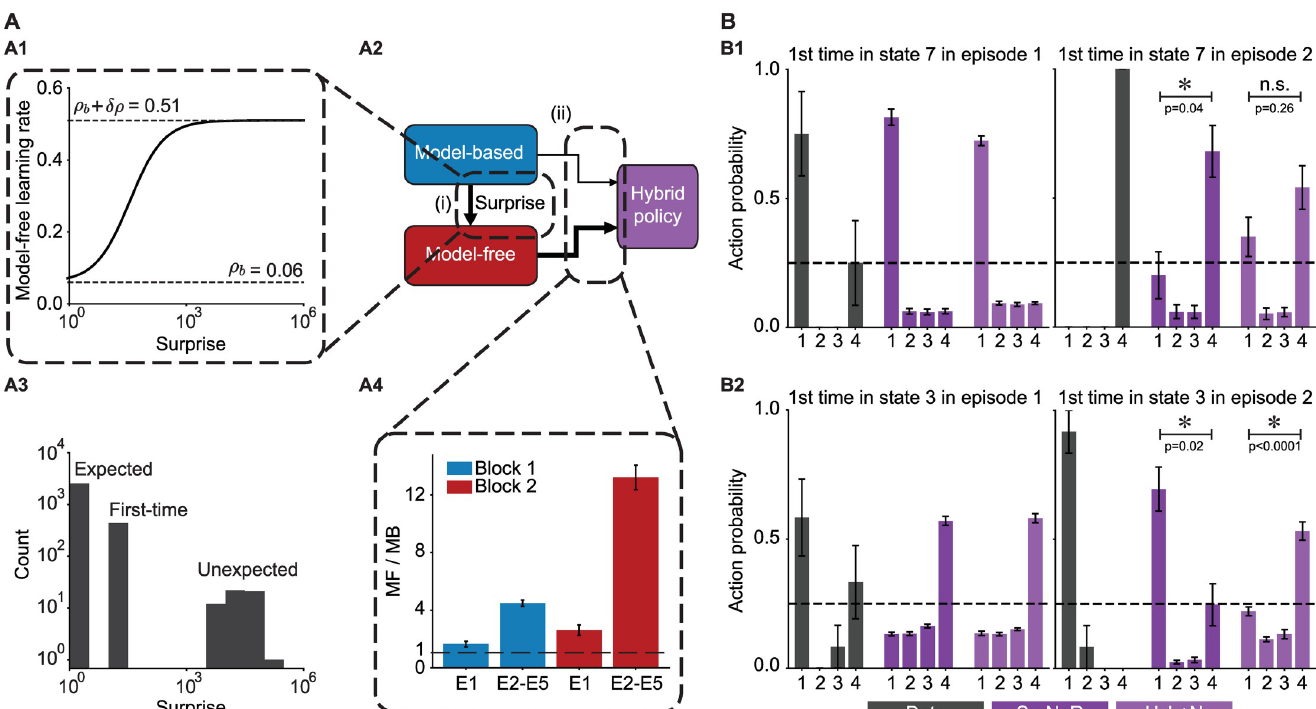
Fig 6. A . Model-based surprise modulates model-free learning . A1 . The learning rate of the model-free branch as a function of the model-based surprise, after fitting parameters to the behavior of all participants (see Eq 9 in Methods). The model-free learning rate for highly surprising transitions is more than 8 times greater than the one for expected transitions. A2 . Three modules from the block diagram of Fig 4C. There are two types of interactions between the model-based and the model-free branches of SurNoR: (i) The model-based branch modulates the learning rate of the model-free branch and (ii) the weighted (arrow thickness) outputs of the model-based and the model-free branches influence action selection (hybrid policy). A3 . The histogram of surprise values across all trials of 12 participants. The distribution is multimodal with high surprise for the unexpected transitions in the 1st episode of block 2, medium surprise for whenever a transition is experienced for the first time, and low surprise for the expected transitions. A4 . The relative importance of model-free (MF) compared to model-based (MB) in the weighting scheme of the hybrid policy during different episodes. Vertical axis: dominance of model-free (see Methods). Values larger than one (dashed line) indicate that the model-free branch dominates action selection. Error bars show the standard error of the mean. B . Action choice probability indicates that surprise boosts learning during a single episode . Action choice probabilities of participants (data, grey) are compared with those of SurNoR and Hyb+N at the fist time visiting state 7 ( B1 ) or state 3 ( B2 ) in episodes 1 (left) and 2 (right) of block 2. B1 . In state 7, action 1 is the good action before the swap, and action 4 is the good action after the swap. Error bars show the standard error of the mean, and the black dashed line corresponds to random choice action probability (0.25). In episode 2, SurNoR assigns a significantly higher probability to action 4 than to action 1, while according to the Hybrid model without surprise modulation, the action probabilities of action 1 and action 4 are not significantly different. B2 . In state 3, action 4 is the good action before the swap, and action 1 is the good action after the swap. Behavioral data and SurNoR show a more rapid re-adaptation to the good action than Hyb+N. Note that only 8 (out of the 12) participants encountered state 7 in the first episode of block 2 before reaching the goal. We therefore limit the data analysis to these 8 participants in B1 but use data of all 12 participants in